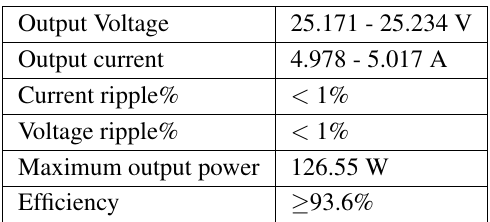
Table 2. Simulation